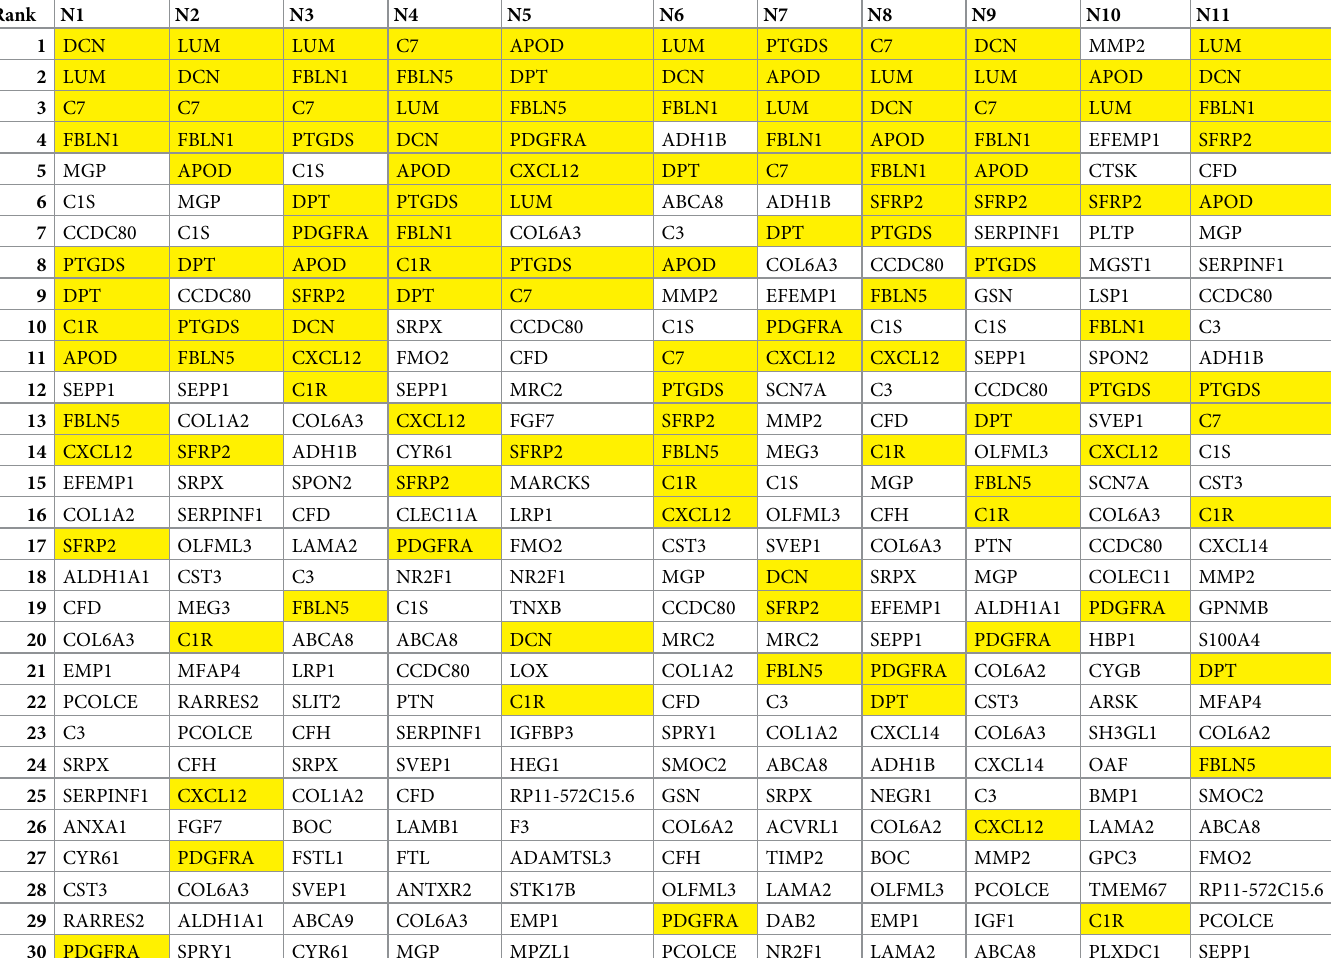
Table 2. Top 30 genes of the identified attractors for each pancreatic normal sample (N1-N11). 12 commonly shared genes in at least ten of the eleven normal sam- ples are